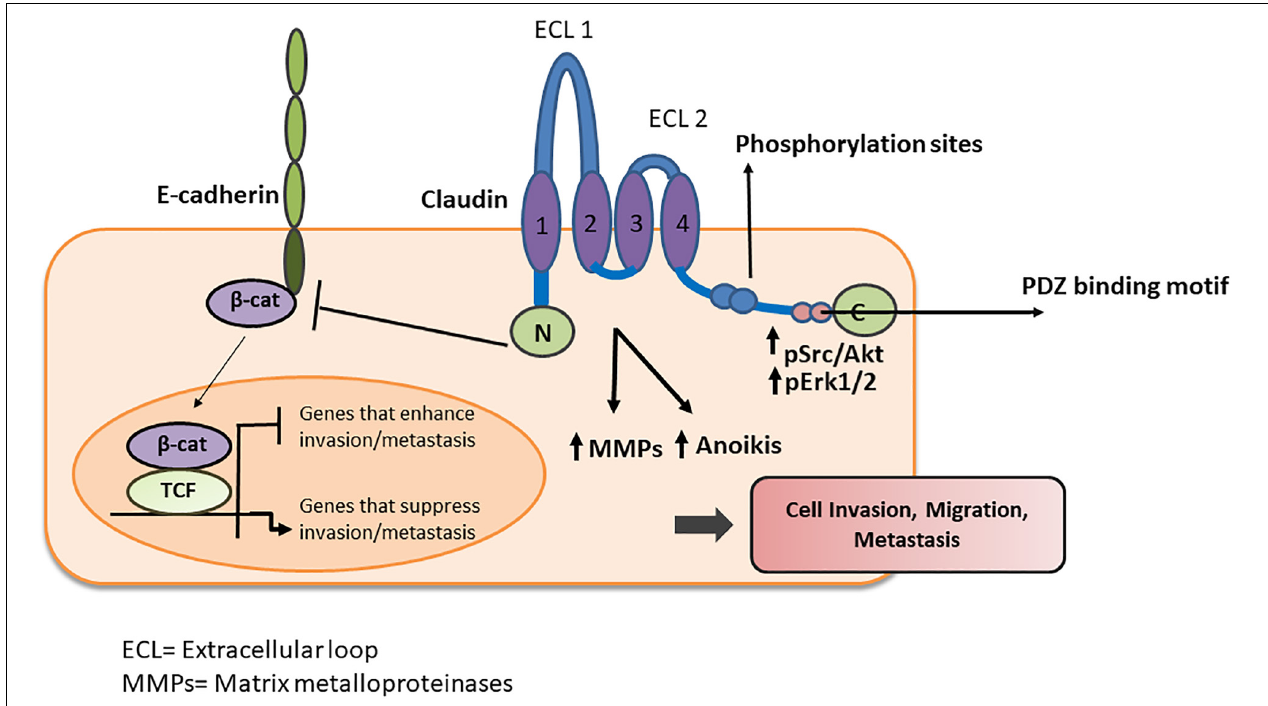
FIGURE 5 | Schematic representation of claudin interaction with adhesion molecules and signaling proteins. Claudins and claudin containing complexes influence diverse signaling processes within cancer cells that results in altered migration, invasion and metastasis. Claudins either interact directly with other adhesion molecules or recruit signaling proteins to execute their diverse array of